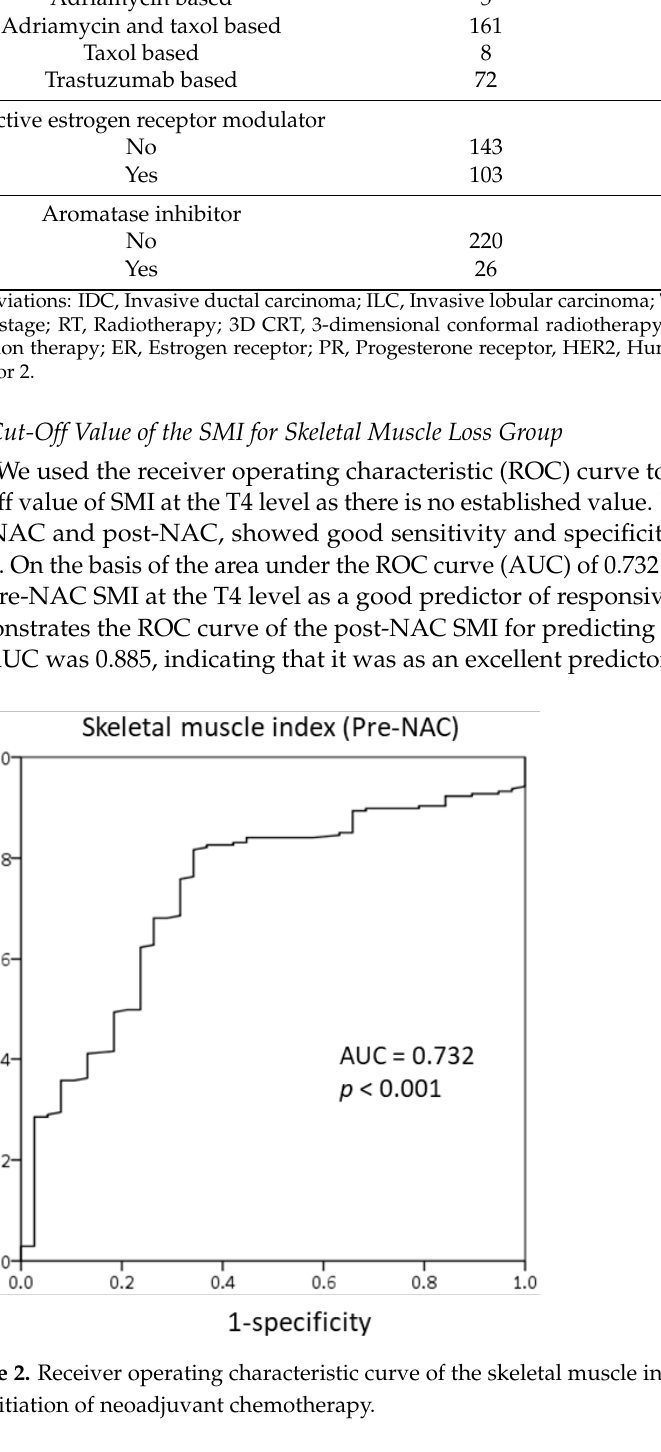
Figure 3. Receiver operating characteristic curve of the skeletal muscle index at the T4 level after the completion of neoadjuvant chemotherapy. 3.3. Predictive Value of Subcutaneous Adipose Tissue Index We also analyzed the subcutaneous adipose tissue index (SATI) to evaluate whether the SATI can predict the response to NAC. Both the pre-NAC and post-NAC SATI showed poor specificity and sensitivity in predicting responsiveness to NAC (Figures S1 and S2). The AUCs of pre-NAC and post-NAC SATI were 0.560 and 0.587, respectively, indicating SATI to be a poor predictive tool.